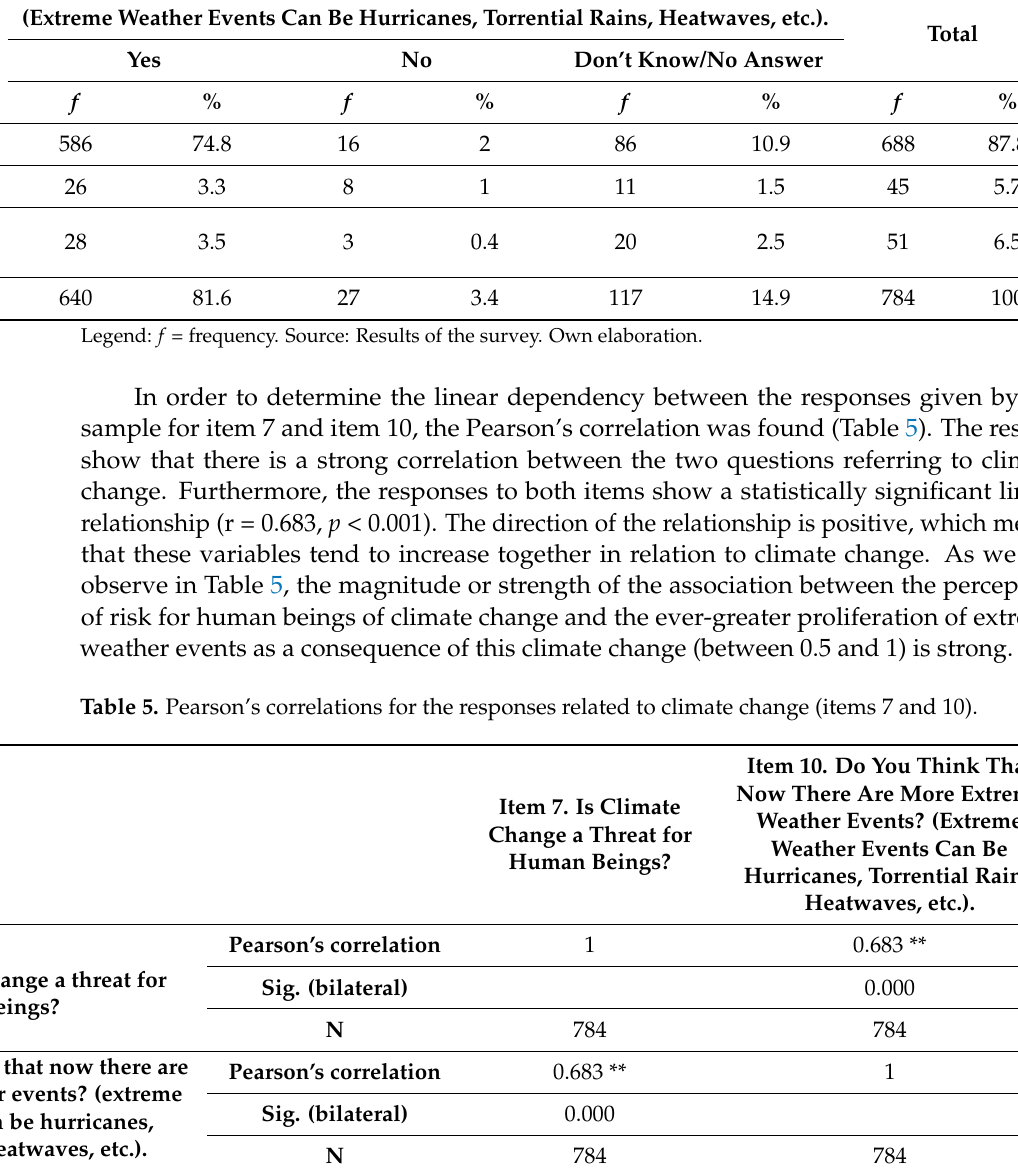
Table 4. Frequency and percentages of the perception of students in relation to climate change and the development of associated extreme weather phenomena.